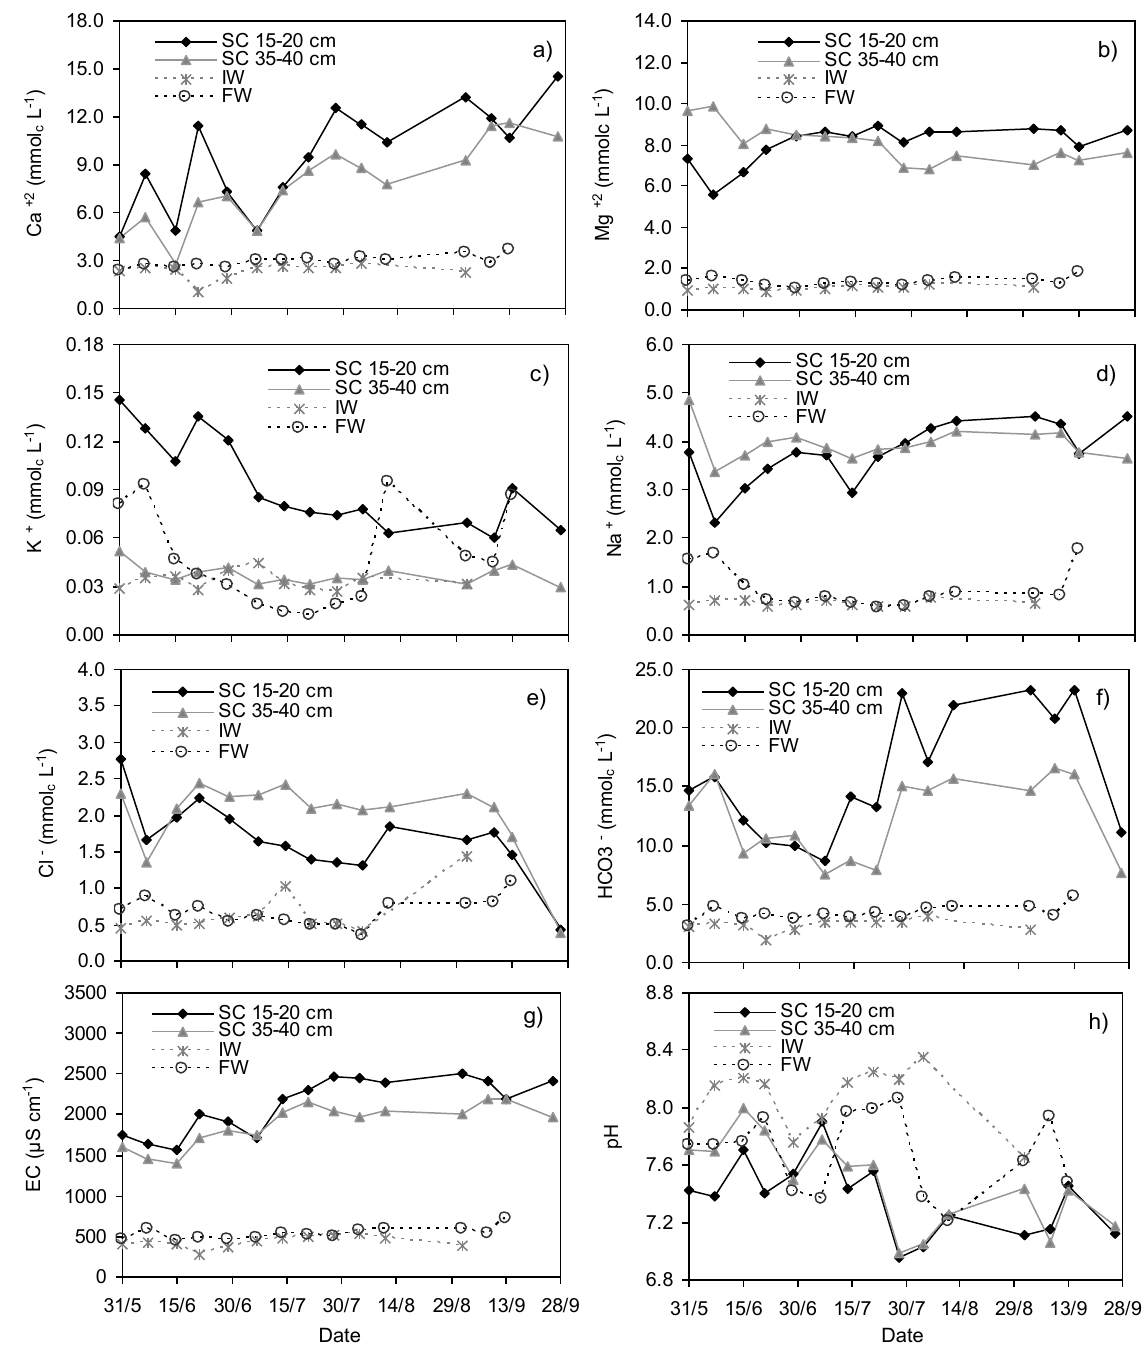
Figure 2. Variation of salinity components in the soil solution obtained from suction cups of soil layers 15–20 and 35–40 cm, in the irrigation water and in the floodwater (SC: soil solution, IW: irrigation water, FW: floodwater) ( a ) Ca 2+ concentration; ( b ) Mg 2+ concentration; ( c ) K + concentration; ( d ) Na + concentration; ( e ) Cl − concentration; ( f ) HCO 3− concentration; ( g ) Electrical conductivity (EC) and ( h )